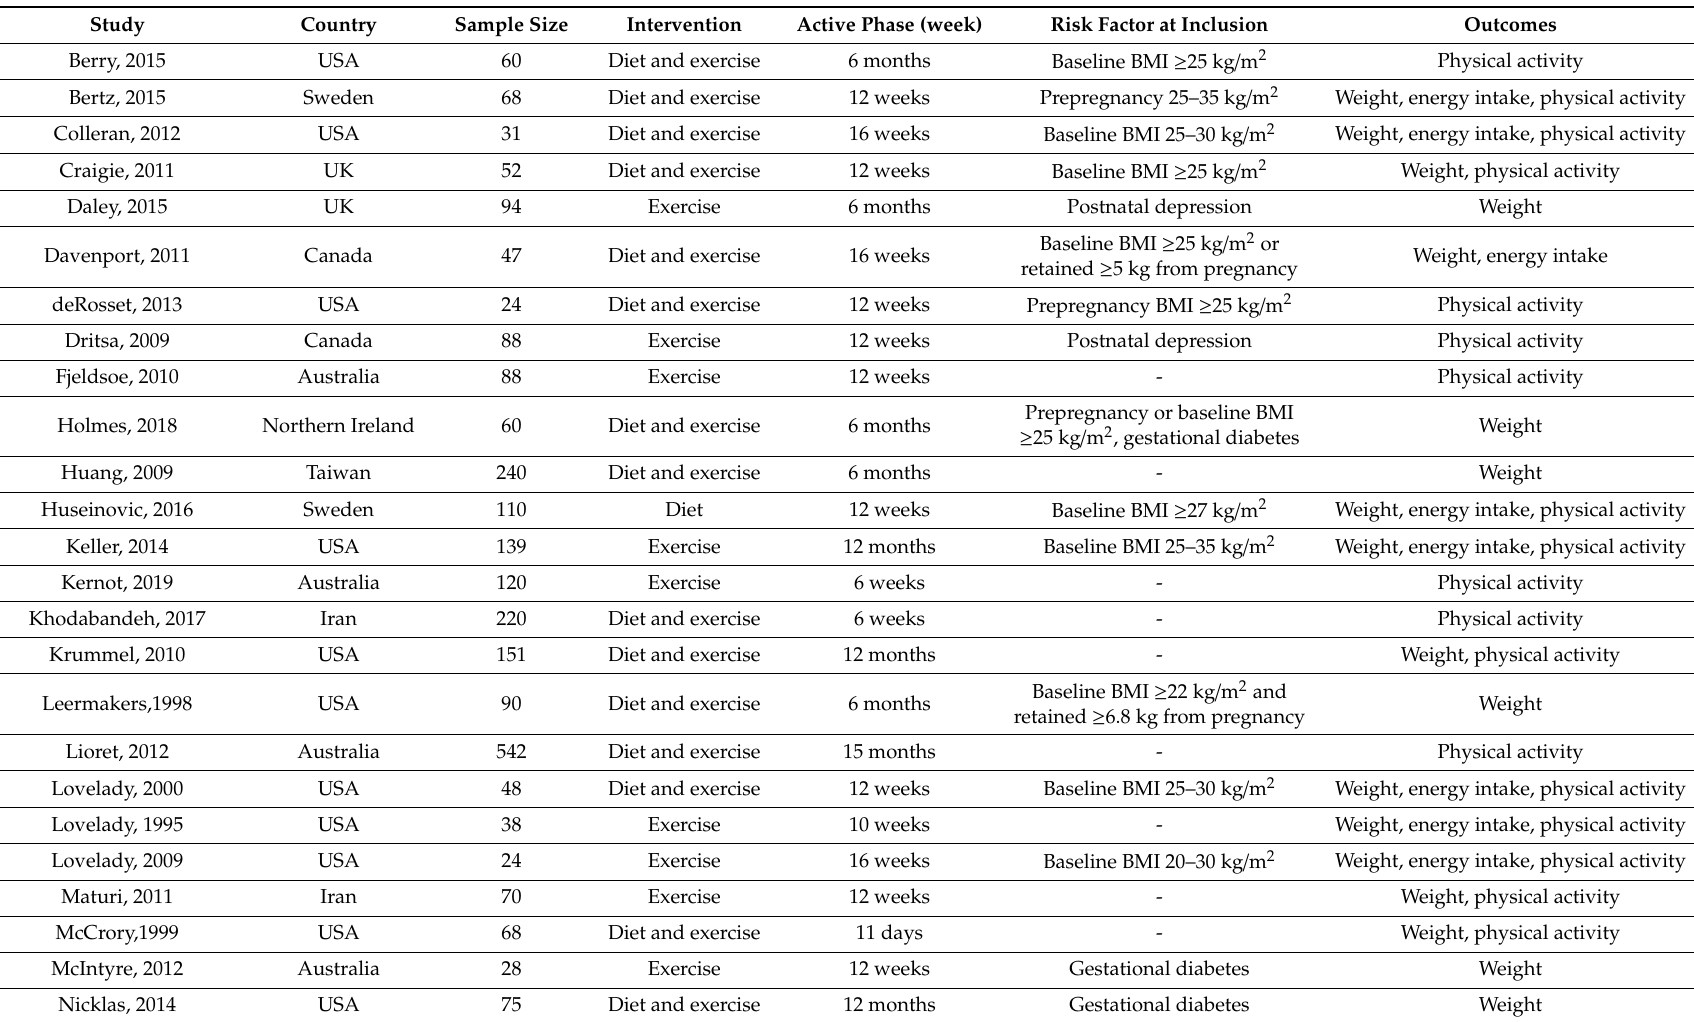
Table 1. Characteristics of included